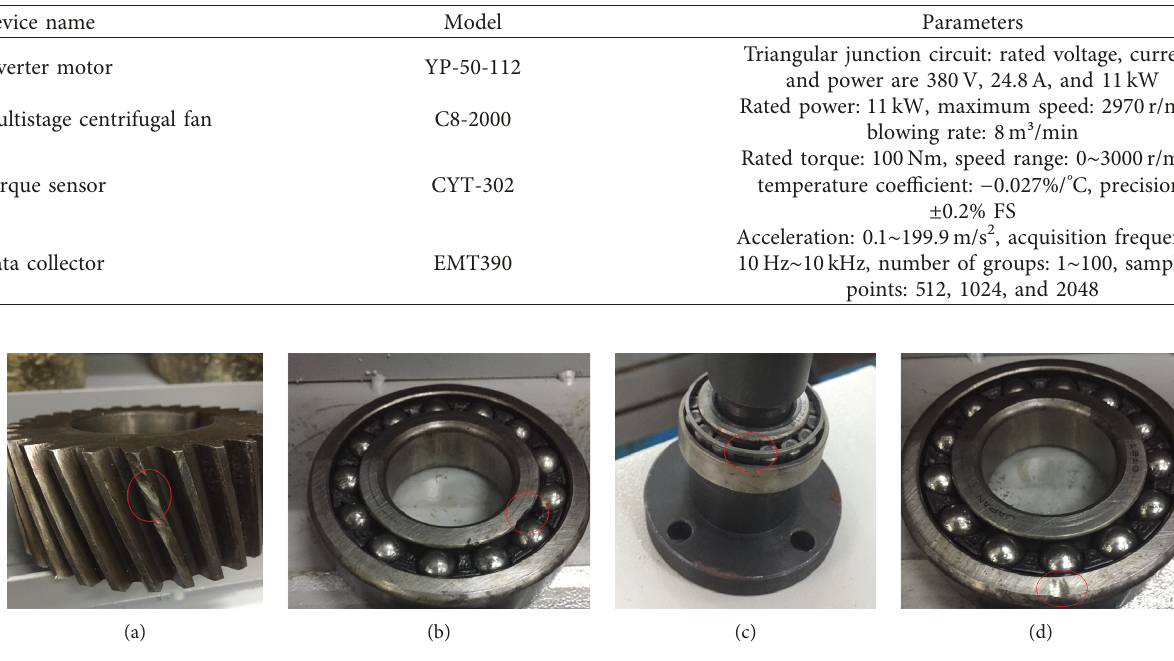
Table 2: Main parts of the experimental unit.